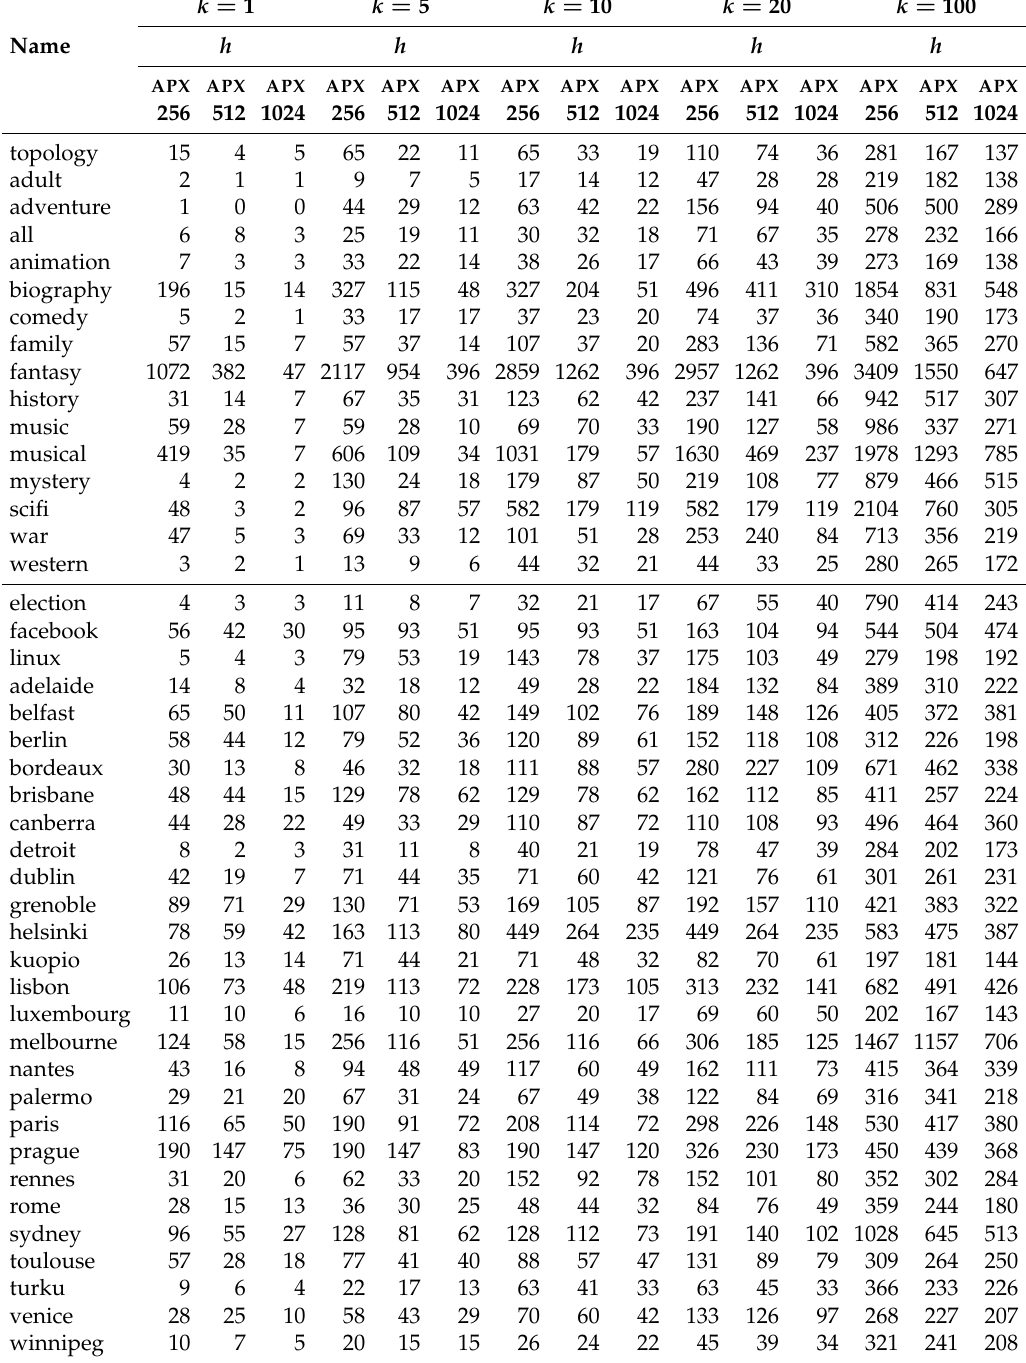
Table A4. Maximum position of the top- k nodes (for the exact ranking) in the approximate ranking computed by APX - h (over 50 experiments) in the case of the temporal graphs included in our dataset (excluding TWIT for which the exact ranking could not be